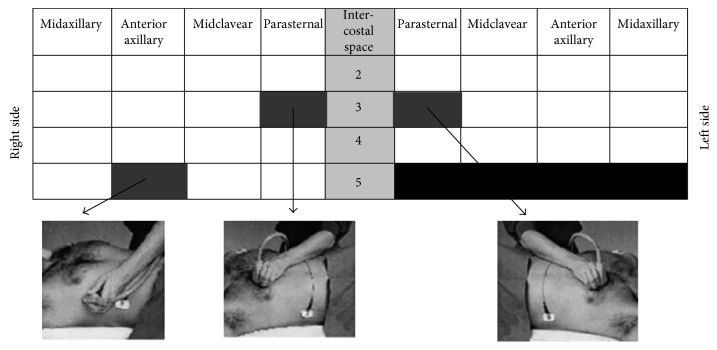
Lung ultrasound scanning for B-lines (cited from L Gargani et al., “Ultrasound lung comets for the differential diagnosis of acute cardiogenic dyspnea: a comparison with natriuretic peptides,” European Journal of Heart Failure, 10 (2008) 70–77).